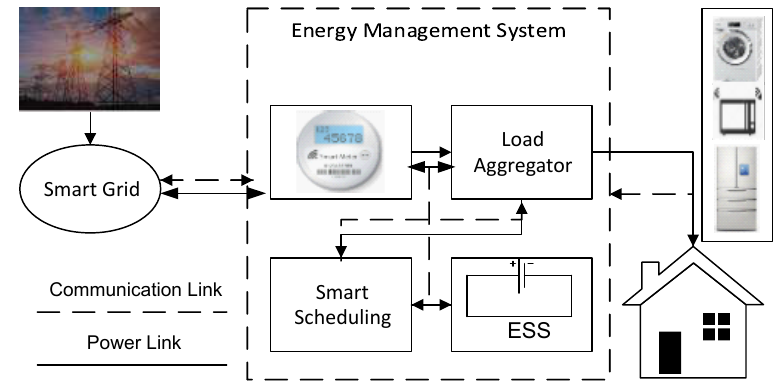
Figure 1. Architecture of Smart